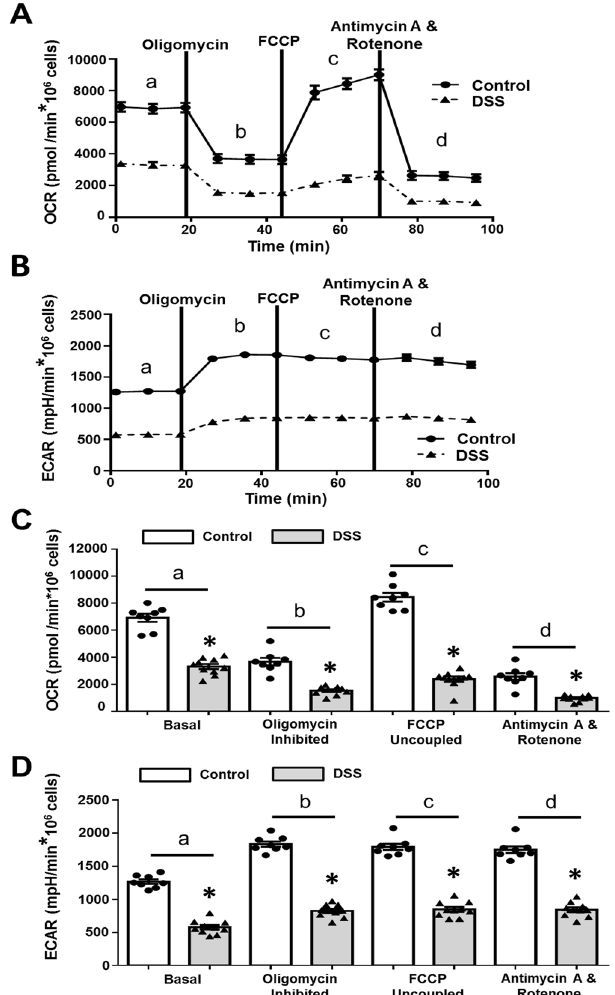
Figure 1. Results of Cell Mito Stress Protocol for IEC 4.1 ± 2% DSS 24 h treatments using the Seahorse XF24 Analyzer. Graphs ( A , B ) represent tracings of oxygen consumption rates (OCR) and extracellular acidification rates (ECAR) respectively. Regions of metabolic significance are highlighted as (a) basal respiration, (b) Oligomycin-inhibited ATP-linked respiration, (c) FCCP-uncoupled maximal respiration, (d) complete mitochondrial inhibition. Graphs ( C , D ) summarize average OCR and ECAR values for well replicates during regions of metabolic interest. Data is presented as mean ± SEM (n = 8–10 replicates from 2 independent experiments); *Represents significant differences between the control group, p < 0.05; two-tailed independent t-tests for each metabolic region.